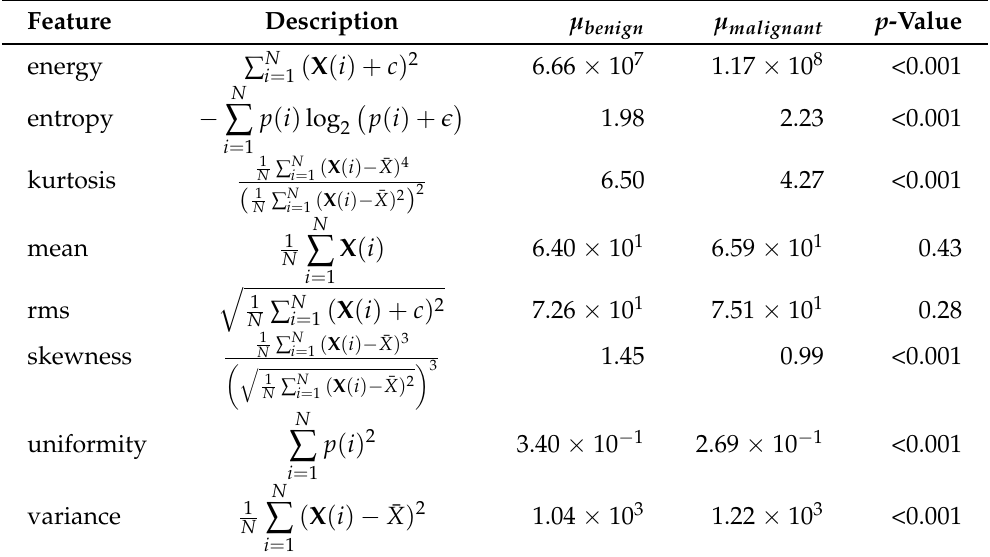
Table A1. First-order Texture Features. The metrics are computed for a set of N pixels inside of the ROI denoted as X . Benign and malignant groups are compared using a t -test.